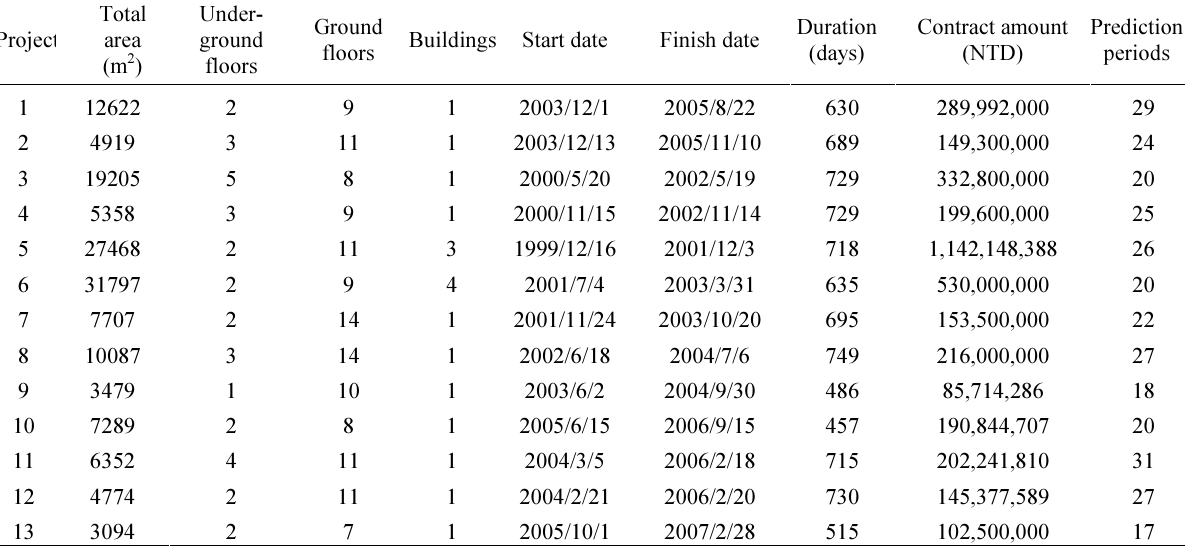
Table 2. Project information